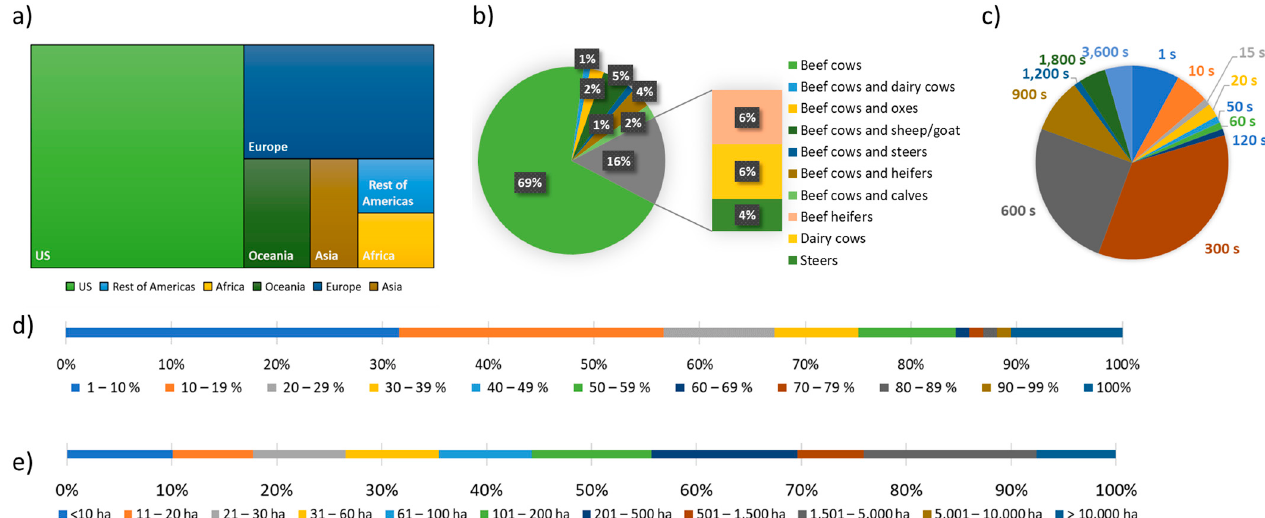
Figure 2. Descriptive statistics of the main characteristics of the 84 studies published between 2000 and 2020 on the use of GPS tracking on cattle to determine the factors affecting their site use preference on grazing systems: ( a ) proportion of studies per region; ( b ) percentage of animal types; ( c ) frequency with which GPS fixes were taken from the collared animals; ( d ) percentage of animals tracked within the herd; ( e ) percentage of paddock size categories.